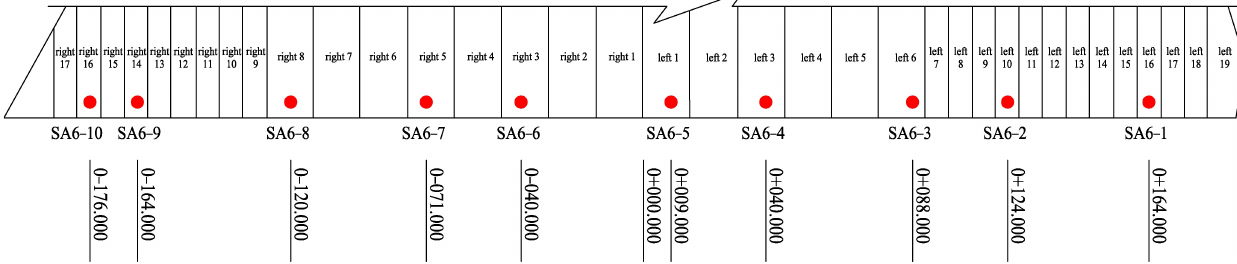
Figure 3. Layout of vertical deformation measuring points.